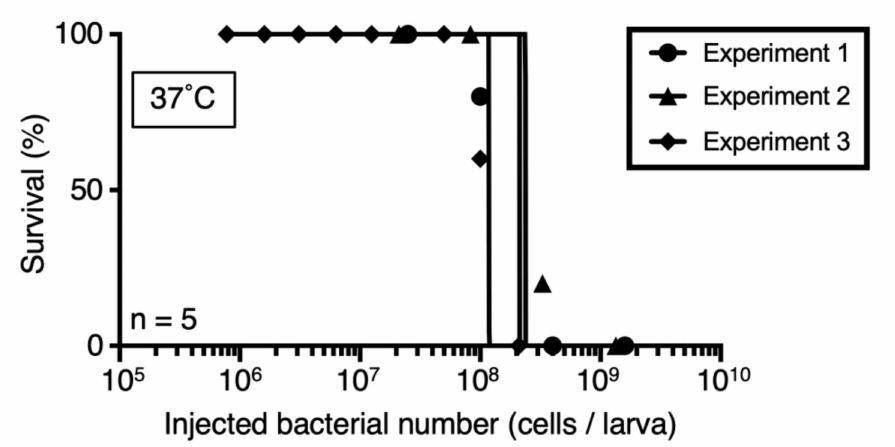
Figure 2. Dose response of C. acnes in the silkworm infection model. Silkworms were injected with saline or C. acnes cell suspension (Experiment 1: 2.5 × 10 7 –1.6 × 10 9 cells/50 µ L, Experiment 2: 2.1 × 10 7 –1.3 × 10 9 cells/50 µ L, or Experiment 3: 7.8 × 10 5 –4.1 × 10 8 cells/50 µ L) and incubated at 37 ◦ C. The number of surviving silkworms was measured at 48 h after injection. n =